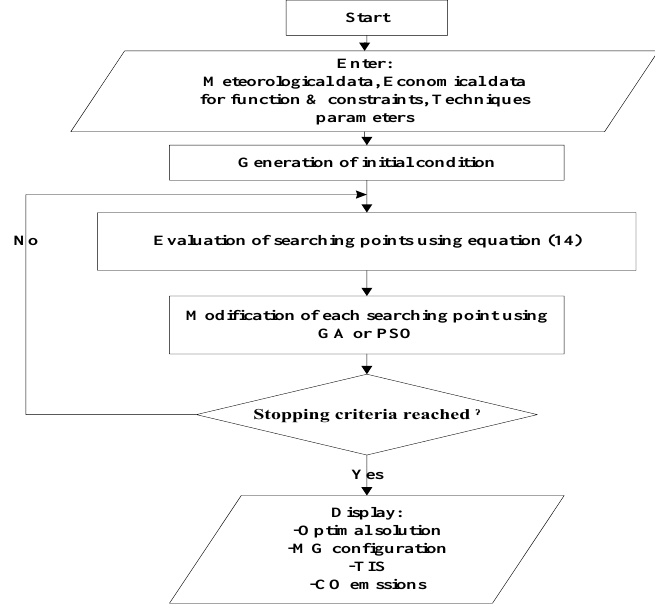
Figure 3. Computational procedure flow chart using PSO or